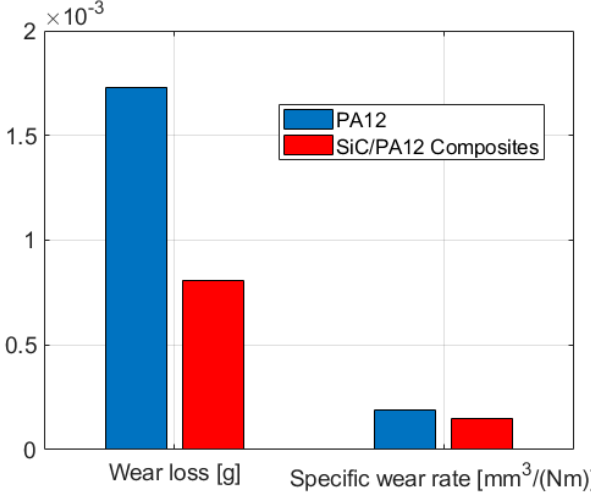
Figure 6. The wear loss and specific wear rate of PA12 and PA12/SiC composite.